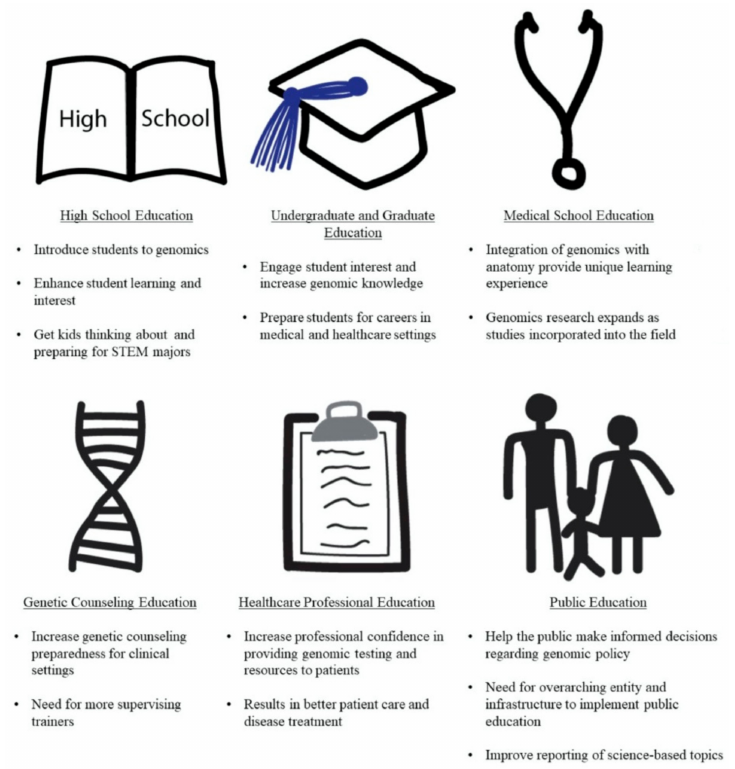
Figure 5. Summary of the importance of and needs for genomic education across various academic, professional, and public